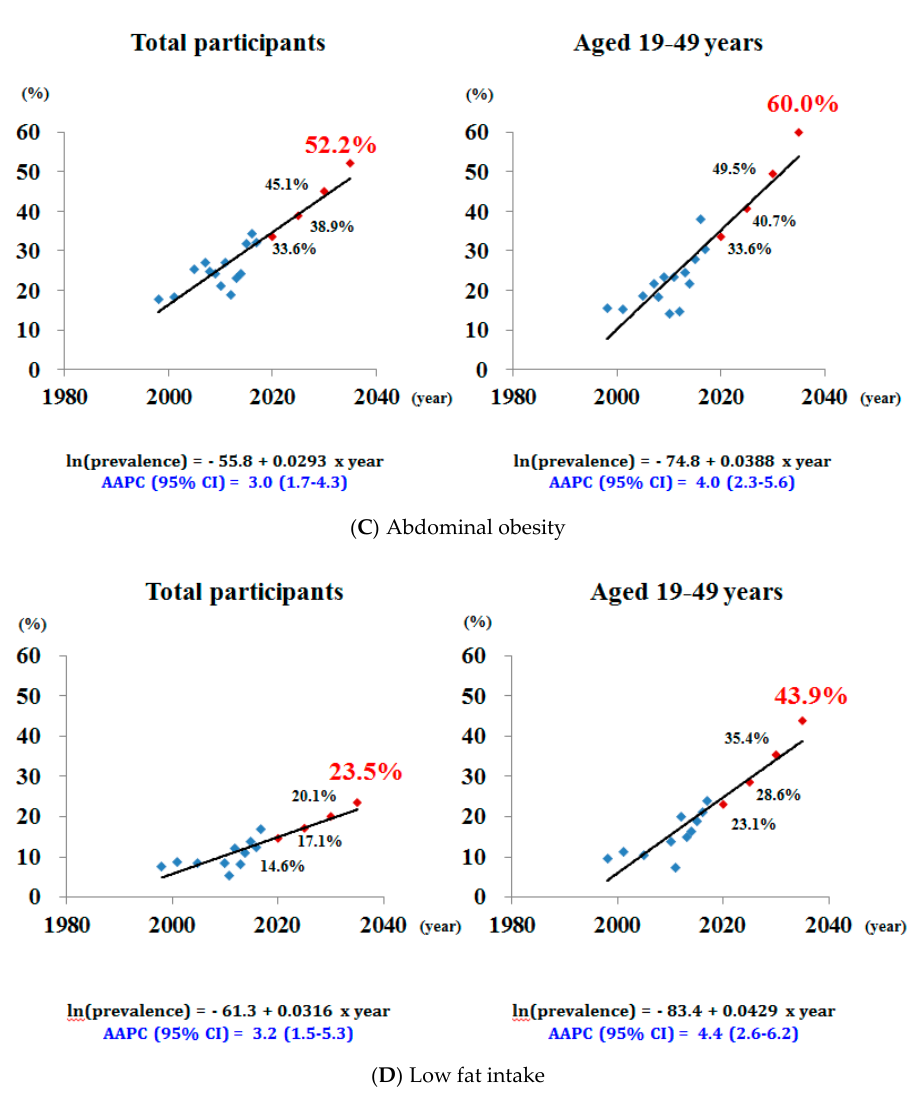
Figure 2. Future predictions using the joinpoint model for the prevalence of NAFLD and associated risk factors in the total participants and young Korean men. NAFLD, non-alcoholic fatty liver disease; AAPC, average annual percentage change.